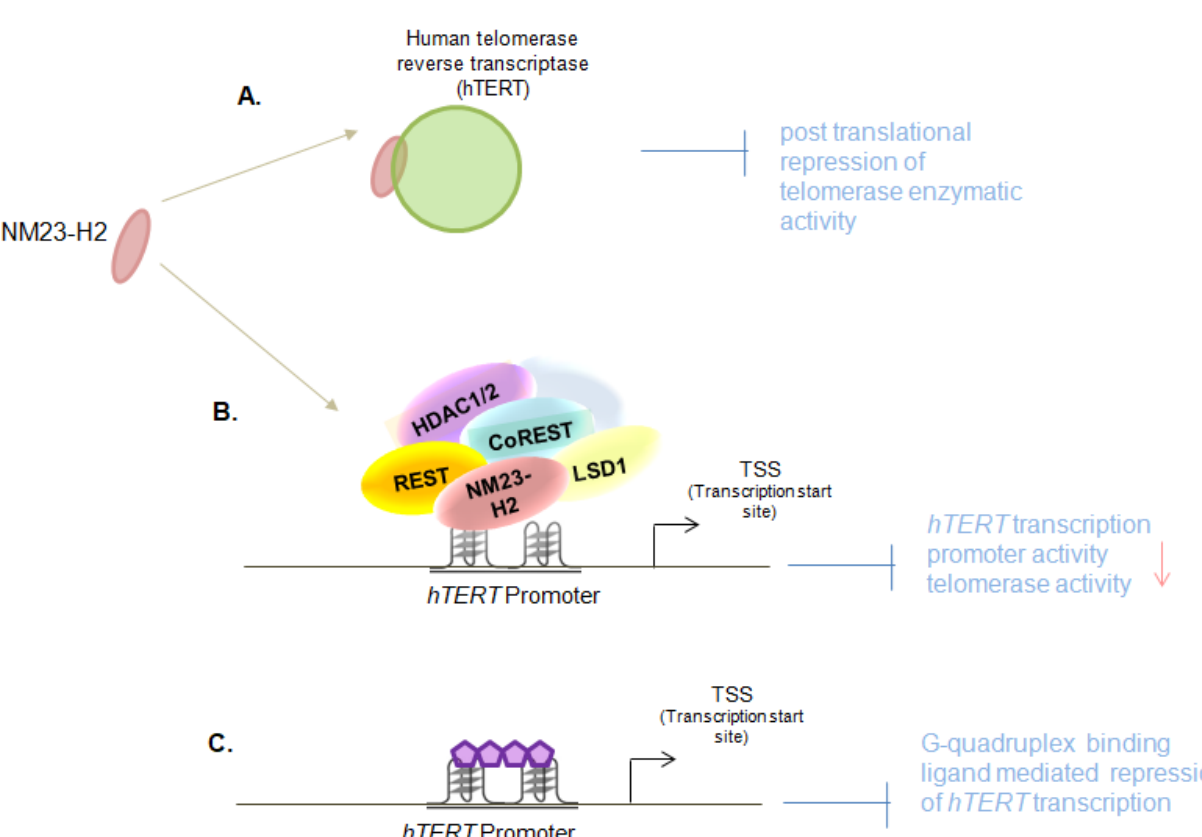
Figure 2. Dual regulation of human telomerase reverse transcriptase (hTERT) by NM23-H2: ( A ) NM23-H2 associates with the hTERT protein and represses the telomerase enzymatic activity [5]; ( B ) NM23-H2 directly binds the hTERT promoter and represses hTERT transcriptionally by recruiting REST/co-REST/LSD1/HDAC1/2 repressor complex on the hTERT promoter in a G-quadruplex dependent manner; ( C ) G-quadruplex binding ligands alter hTERT promoter epigenetics similar to G-quadruplex binding protein, NM23-H2